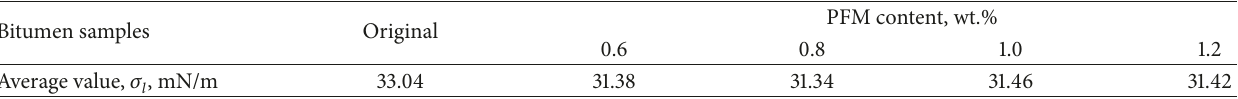
Table 7: Surface tension of the bitumen